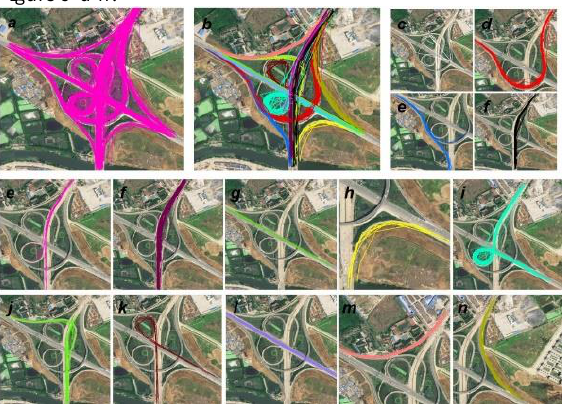
Figure 9. Clustering results of Qingling overpass in